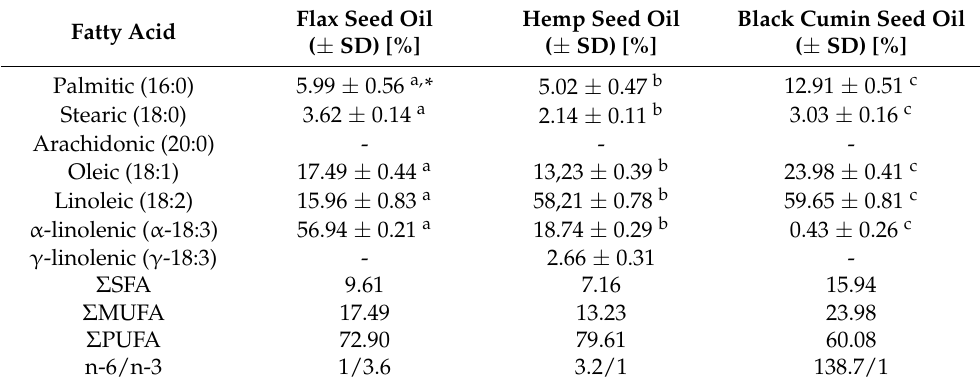
Table 2. Average fatty acid composition in the analyzed